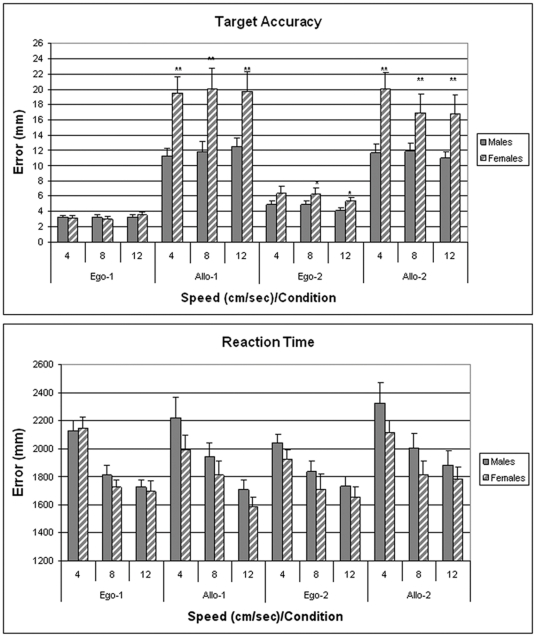
Data shown in the upper panel are the mean (±SEM) for target accuracy measured under egocentric and allocentric perspectives for 18 males and 17 females tested in Experiment 1.Data are expressed as millimeters of deviation from zero. *p<0.05, **p<0.01 from males in same condition/speed. Mean reaction times (±SEM) for the targeting response are shown the lower panel.